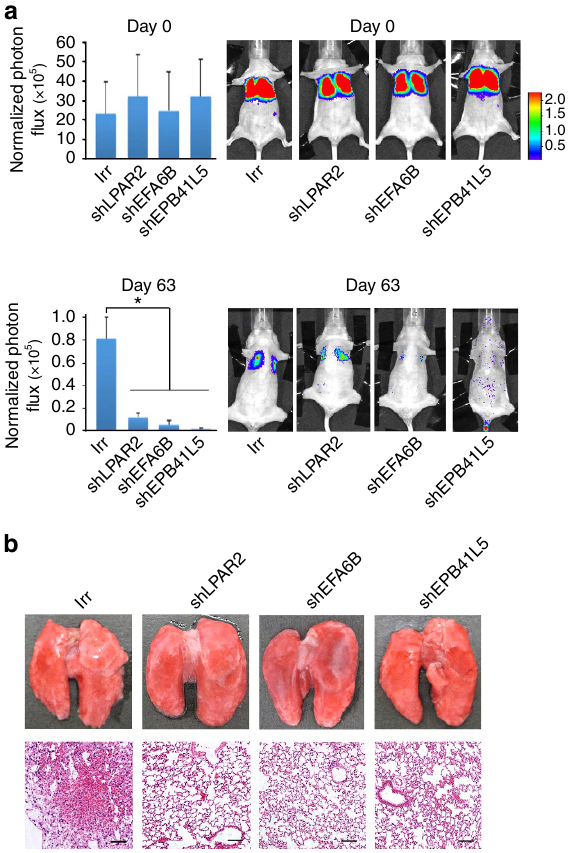
Figure 6 | Requirement for LPAR2 and the Arf6 mesechymal pathway in the lung metastasis. 786-O cells expressing a luciferase reporter gene and shRNA plasmids, each targeting EPB41L5 (shEPB41L5), EFA6B (shEFA6B) or LPAR2 (shLPAR2), were injected into tail veins of nude mice. Cells treated with shRNA plasmids bearing an irrelevant sequence (Irr) were included as a control. ( a ) Bioluminescence intensities of the chests of the mice, measured on day 0 and day 63, are shown. Results are shown as means ± s.d., n ¼ 5. * P o 0.01. Representative bioluminescence images of mice are shown on the right. Statistical analyses were performed using analysis of variance. ( b ) Representative images of lungs on day 63 post injection. Images of whole lungs (top) and hematoxylin and eosin staining of sections (bottom). Scale bar, 100 m supplemented with 10% FCS. 293FT cells were purchased from Invitrogen, and cultured at 37 (cid:2) C according to the manufacturer’s instructions. Plat-E cells were a gift from Dr Kitamura (Tokyo University), and were cultured at 37 (cid:2) C in DMEM containing 10% FCS. All cell lines were determined to be free of mycoplasma using cytochemical staining of DNA with 4’,6-diamidino-2- phenylindole (Sigma-Aldrich). No antibiotics were used in our cell cultures to avoid latent infection of mycoplasma to cultured cells. Ligand stimulation . Cells were starved for 12h with RPMI supplemented with 0.5% FCS, before stimulation by ligands. Ligands used were LPA (5nM, Santa Cruz), transforming growth factor b 1 (2ngml (cid:2) 1 , R&D Systems), hepatocyte growth factor (10ngml (cid:2) 1 , PeproTech), epidermal growth factor (10ngml (cid:2) 1 , PeproTech), vascular endothelial growth factor (10ngml (cid:2) 1 , PeproTech), PDGF-AA (50ngml (cid:2) 1 , PeproTech), PDGF-BB (50ngml (cid:2) 1 , PeproTech) and insulin (5ngml (cid:2) 1 , Sigma-Aldrich). For the Matrigel invasion assay, ligands were added throughout the assay. For measurement of Arf6 activity, pre-starved cells were stimulated by ligands for 5min before analyses. Cell viabilities were measured using Cell Counting Kit-8 (Dojindo Molecular Technologies), according to the manufacturer’s instructions. Chemicals . Temsirolimus (PZ0020) and Sunitinib (PZ0012) were purchased from Sigma-Aldrich. Ki16425 (355025-24-0) and Y27632 (257-00511) were from Wako